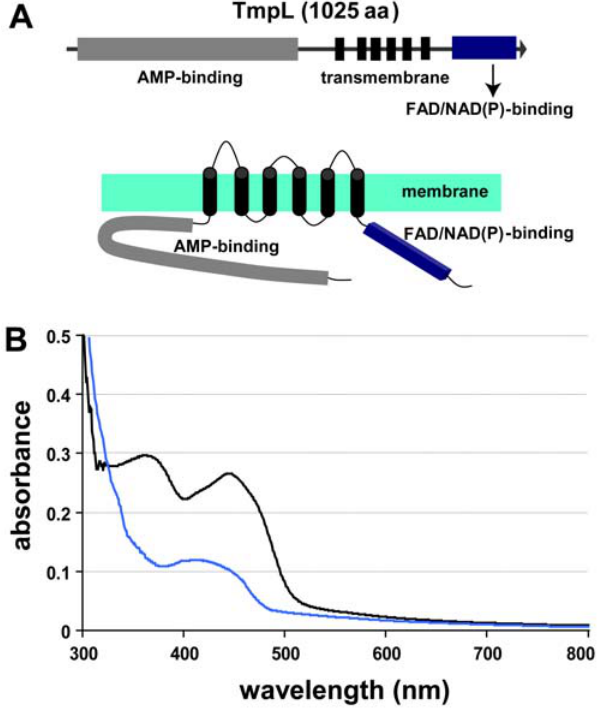
Figure 1. TmpL is a putative membrane flavoprotein. ( A ) Domain organization of TmpL. The predicted protein encoded by the tmpL gene is comprised of 1025 amino acid residues. This protein contains an AMP-binding domain, six putative transmembrane domains, and a FAD/NAD(P)-binding domain. The bottom picture shows predicted topological map of the TmpL protein. Regions of TmpL proposed to be hydrophobic membrane-spanning domains or hydro- philic domains facing the cytosol or subcompartmental matrix were identified using the TMHMM (http://www.cbs.dtu.dk/services/TMHMM- 2.0/) and PRED-TMR (http://athina.biol.uoa.gr/PRED-TMR2/). ( B ) UV- visible spectra of TmpL partial recombinant protein containing FAD/ NAD(P)-binding region. The absorbance spectrum shown indicates that the protein contains bound flavin (black line), demonstrating that TmpL is a FAD/NAD(P)-binding flavoprotein. Bovine serum albumin (BSA) was used as a non-flavin binding protein control (blue line). A solution of the FAD-incubated protein (2.0 mg ml 2 1 ) in 50 mM sodium phosphate buffer, pH 7.5, was analyzed.